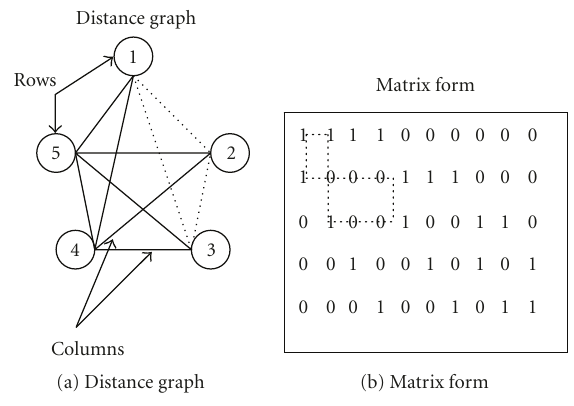
Figure 1: LDPC matrix derived from a distance graph.